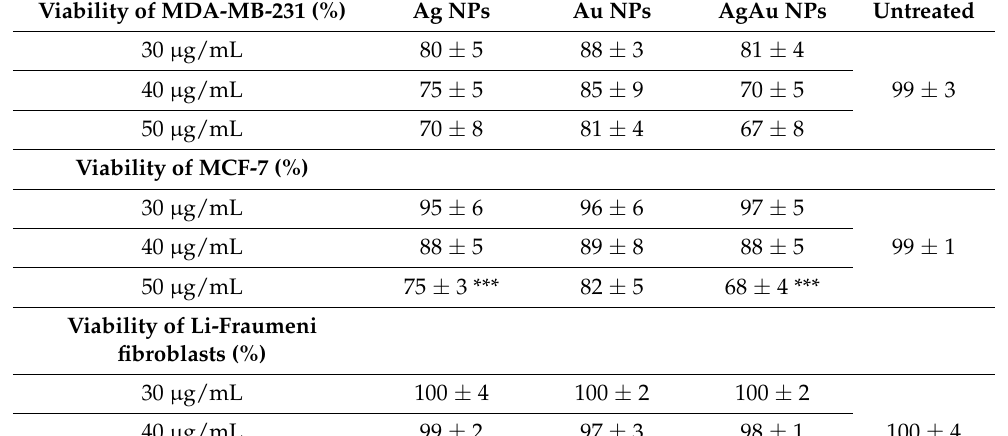
Table 1. Viability percentage ± SD between two experiments of cells incubated with Ag, Au, AgAu NPs (30, 40 and 50 µ g/mL) and untreated cells. The asterisk symbol (***) shows statistical significance using one way ANOVA ( p < 0.05) compared to untreated